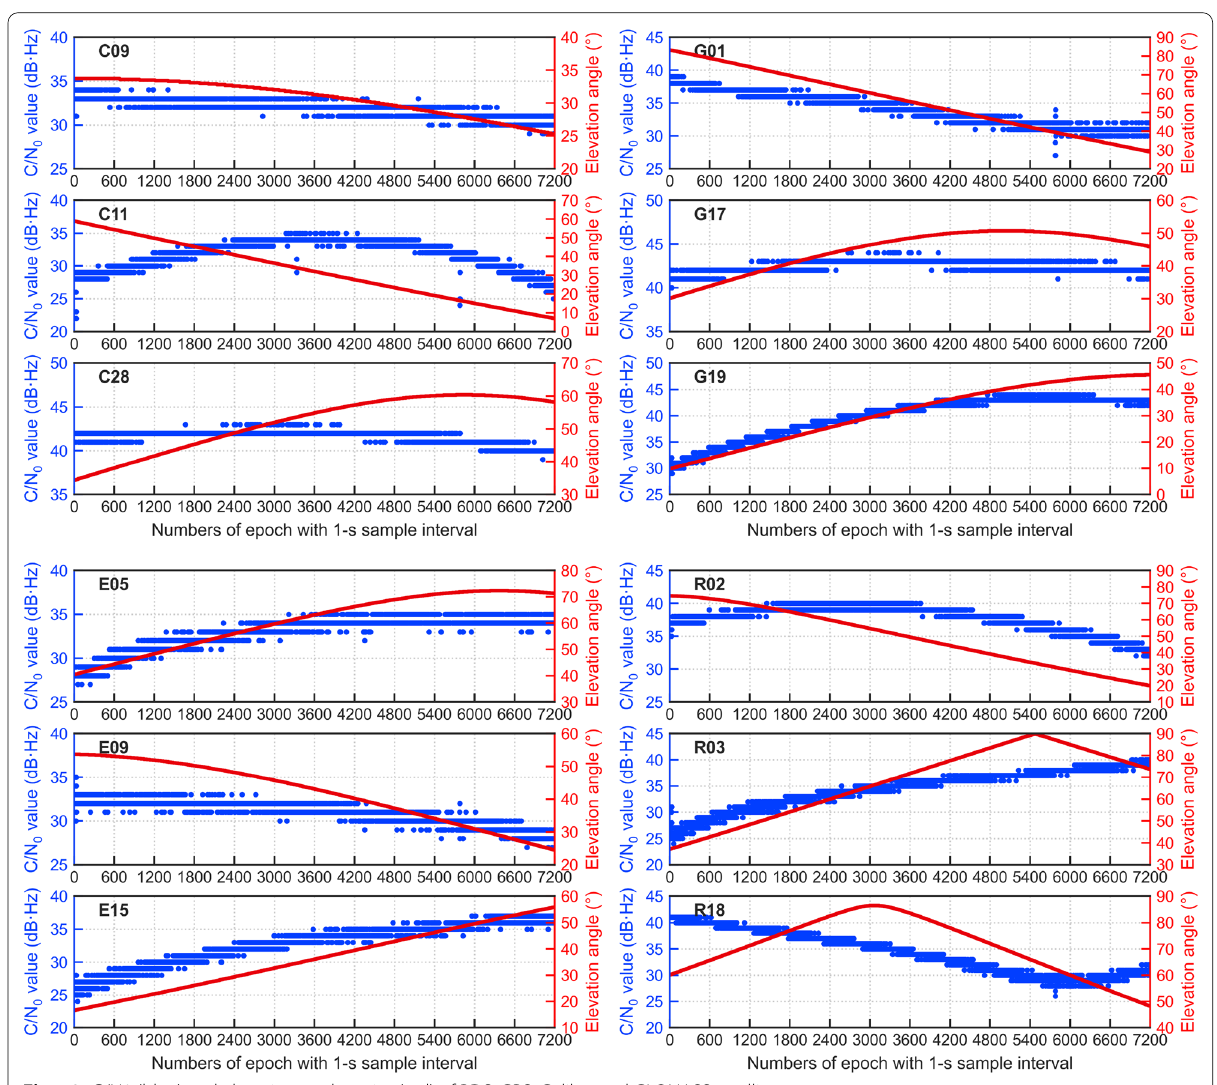
Fig. 13 C/N0 (blue) and elevation angle series (red) of BDS, GPS, Galileo and GLONASS